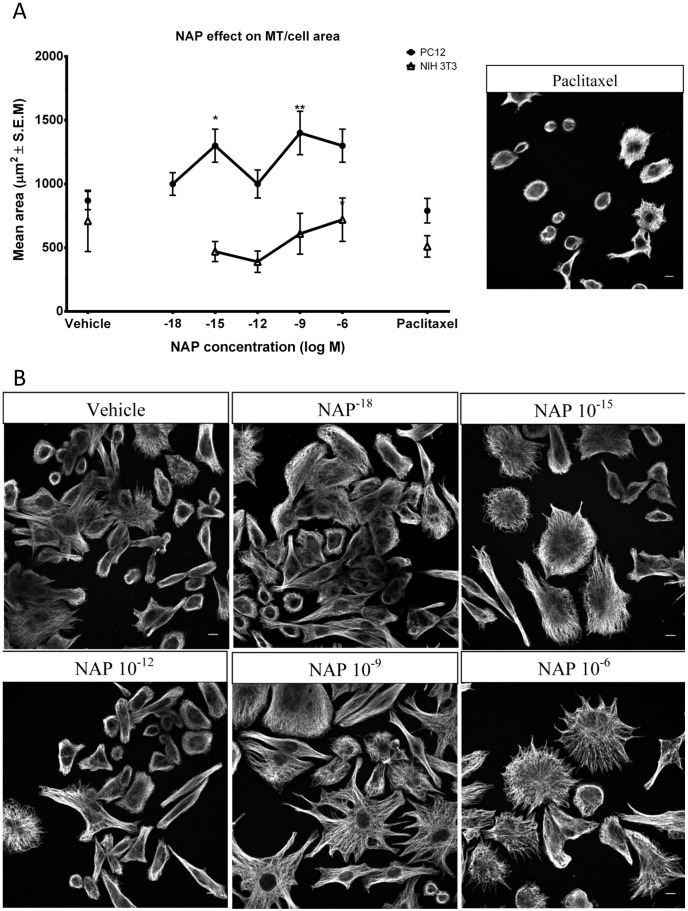
Treatment with NAP increases total polymerized α-tubulin network area in PC12 cells.(a) Concentration response analysis of MT network area/cell as determined by the outer boundaries of fluorescently probed MT (monoclonal anti α-tubulin) in PC12 or NIH3T3 cells, evaluated by image analysis of confocal images. Cultured cells were exposed for 24 hr. to different concentrations of NAP (10−18M - 10−6M) and compared to vehicle-treated cells and paclitaxel, 5 µM treated cells. (PC12 - ANOVA, p = 0.0081, n = 87 cells per treatment; NIH3T3 - ANOVA, p = 0.3892, n = 90). Left side, Representative field-images of PC12 cells treated with paclitaxel with fluorescently probed MT. Bar: 10 µm (b) Representative field-images of PC12 cells with fluorescently probed MT (control and NAP-treated as indicated). Bars: 10 µm.